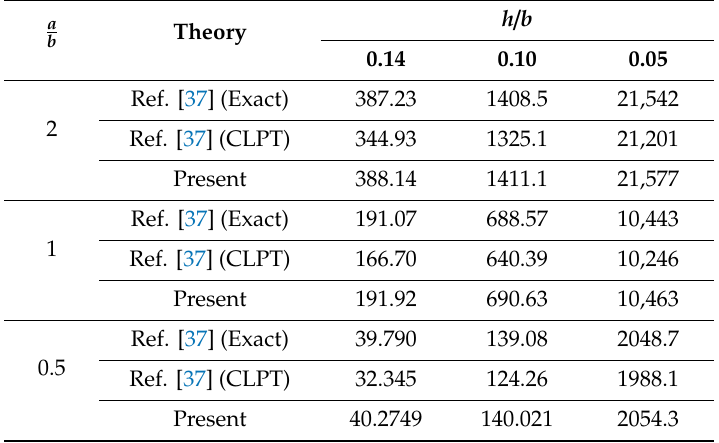
Table 2. E ff ects of thickness and aspect ratios for the orthotropic plate on deflection ˆ w under uniform load (100 term series).